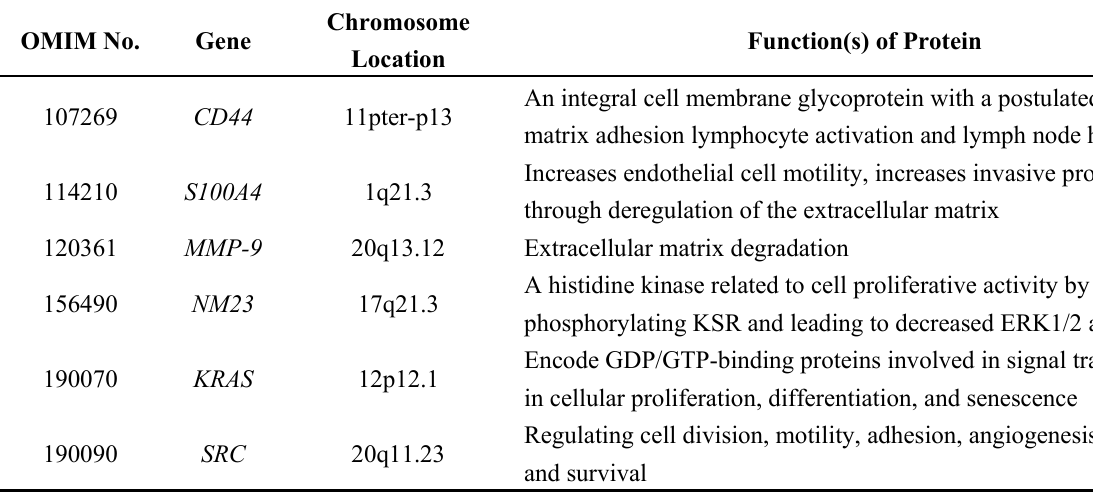
Table 1. Genes associated with metastatic potential of colorectal